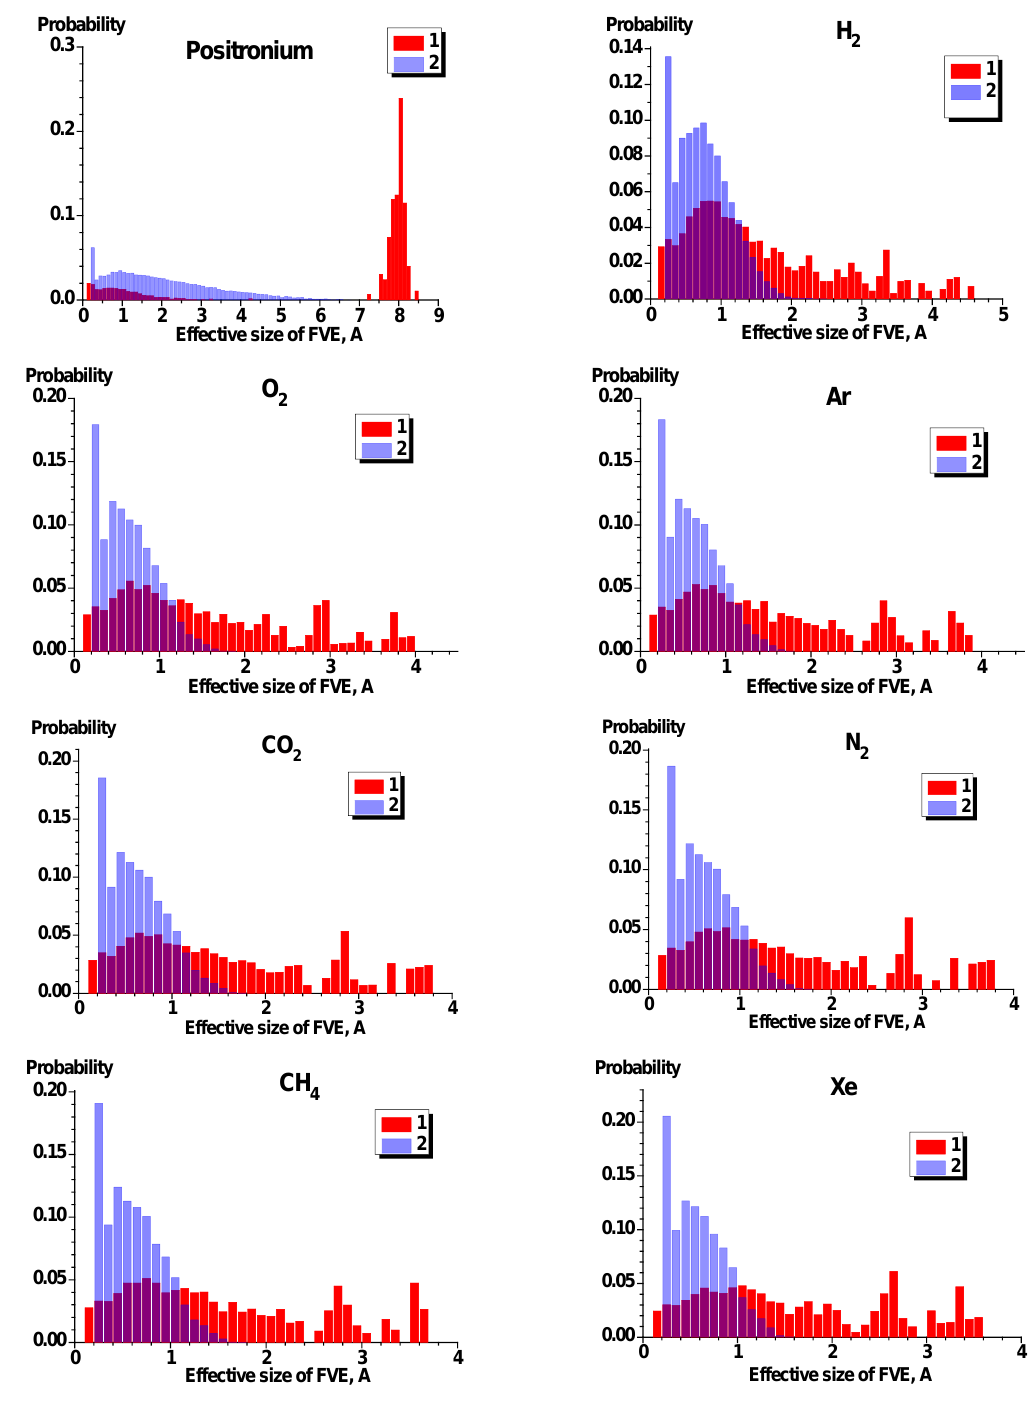
Figure 8. Bar graph distribution of free volume elements (FVEs) accessible for the different gaseous probes calculated from the Ultem (1) and PEI-304 (2) models. Bar graph bin is equal to 0.1 Å.